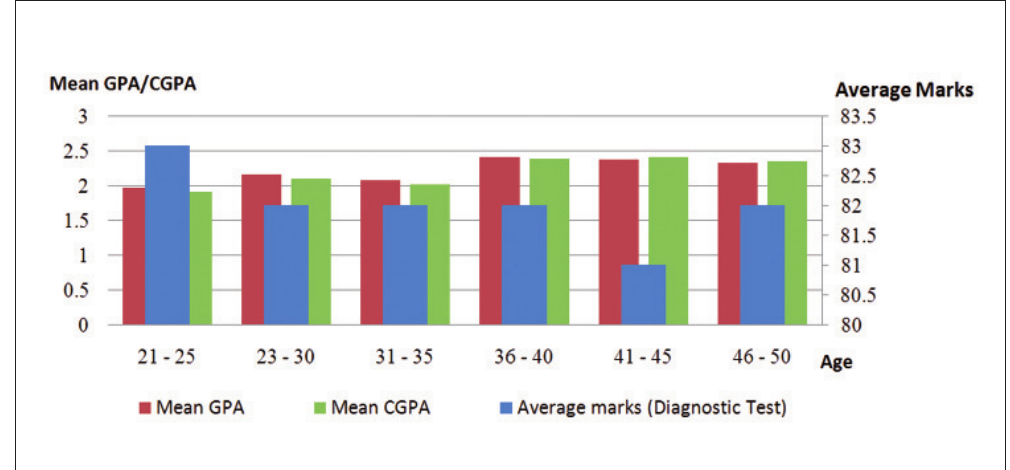
Figure 4 Performance of Group A students who passed the Diagnostic Test and admitted to the undergraduate programmes ( p<0.05